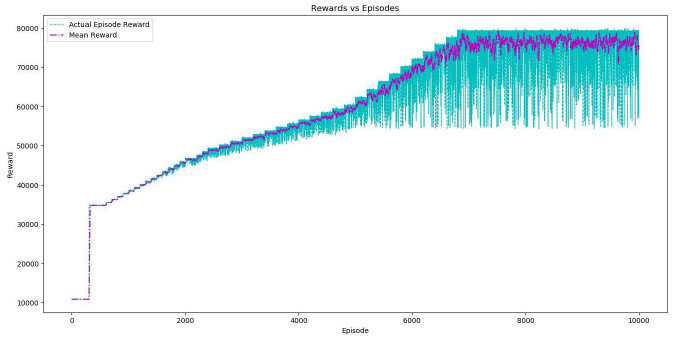
Figure 8. Reward